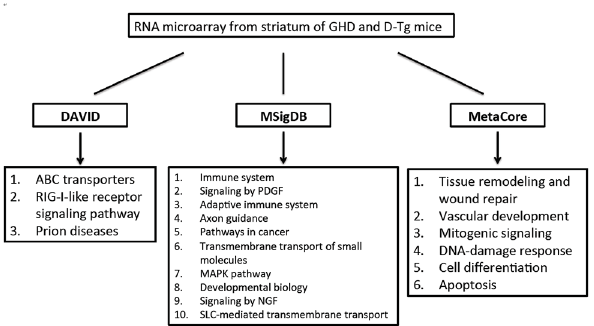
Fig 1. Summary of results from the analyses of different bioinformatic tools. Microarray data (GSE47500) was used to compare the expression profiling between HD transgenic mice (GHD) and HD transgenic mice overexpressing miR-196a (D-Tg). The potential regulatory pathways are listed via different analyses, including DAVID, MSigDB and MetaCore.